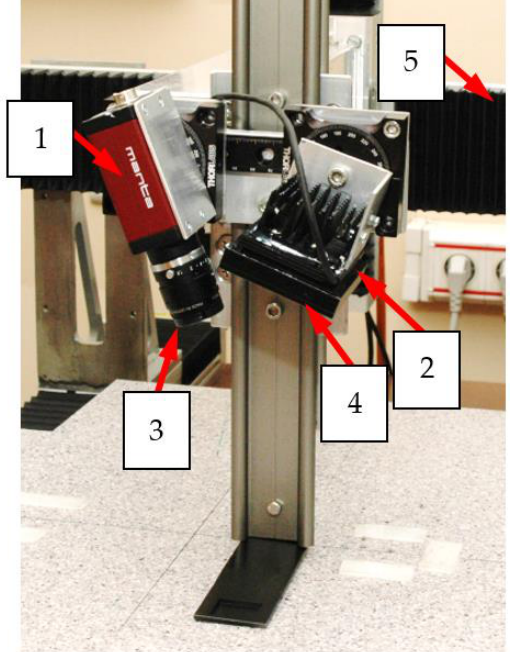
Figure 5. System configurations used in the experiments; ( a ) reference configuration; ( b ) configura- tion of opposite poles magnetization (OPM); ( c ) configuration of same poles magnetization (SPM). In the experiments, a two-dimensional area over the sample surface was scanned. The area directly above the rebars is tested with a positioning system. The example of positioning subsystem is shown in Figure 6.